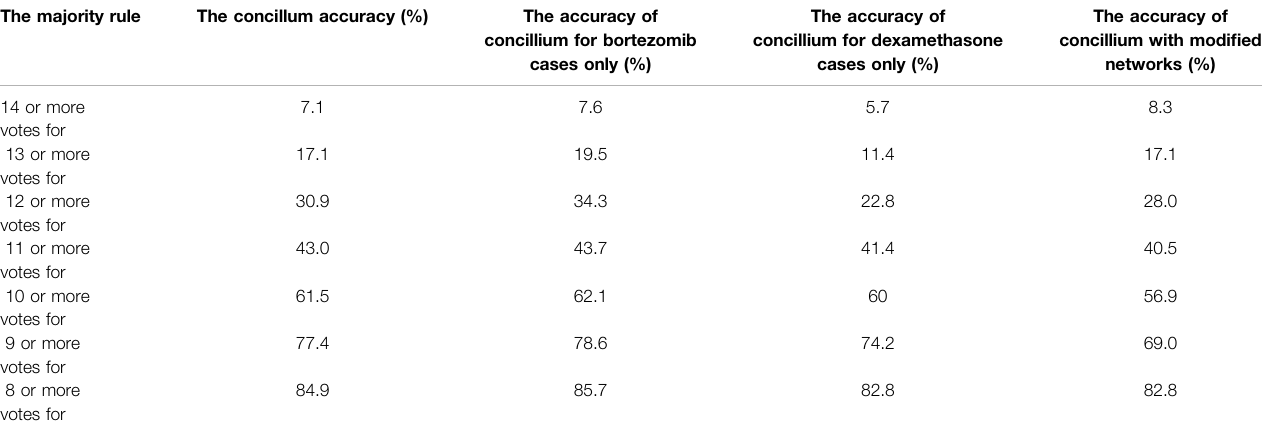
TABLE 5 | The accuracy of determination if the therapy using the bortezomib or dexamethasone drugs is ef fi cient for different majority rules. The results for the optimized network and the network with modi fi ed parameters (cf. Table 6 ) are compared. The majority rule The concillum accuracy (%) The accuracy of